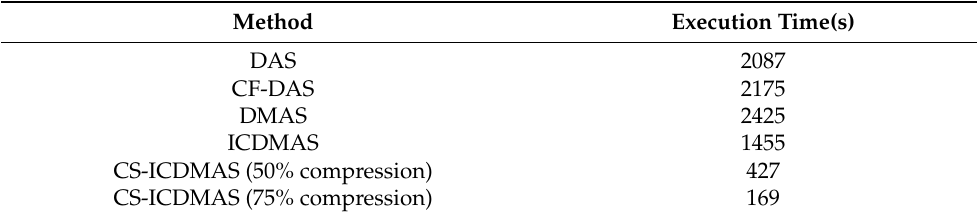
Figure 6. The 8 × 8 scattering matrix measured in the presence of a breast phantom.